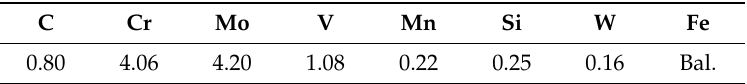
Table 1. Chemical composition of tested M50 bearing steel (wt.